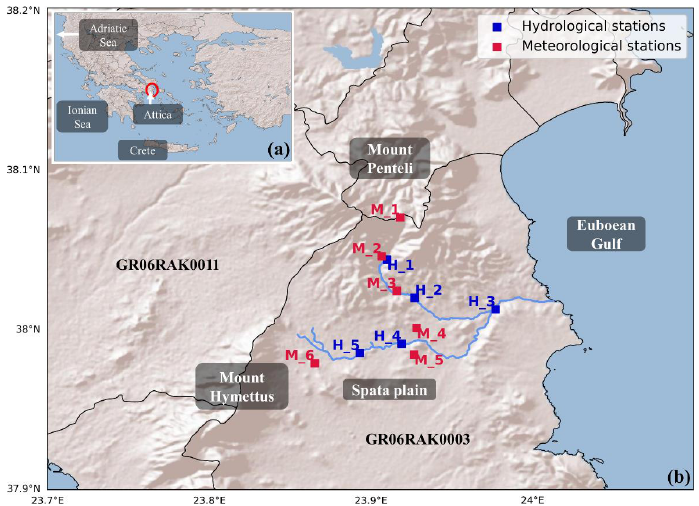
Figure1. ( a )MapofGreecewithidentificationofregionsofinterestand( b )locationsoftheground-based hydrological and meteorological stations with identification of the GR06RAK0003 zone and of the the regional and geomorphological features in the Rafina stream basin. regional and geomorphological features in the Rafina stream